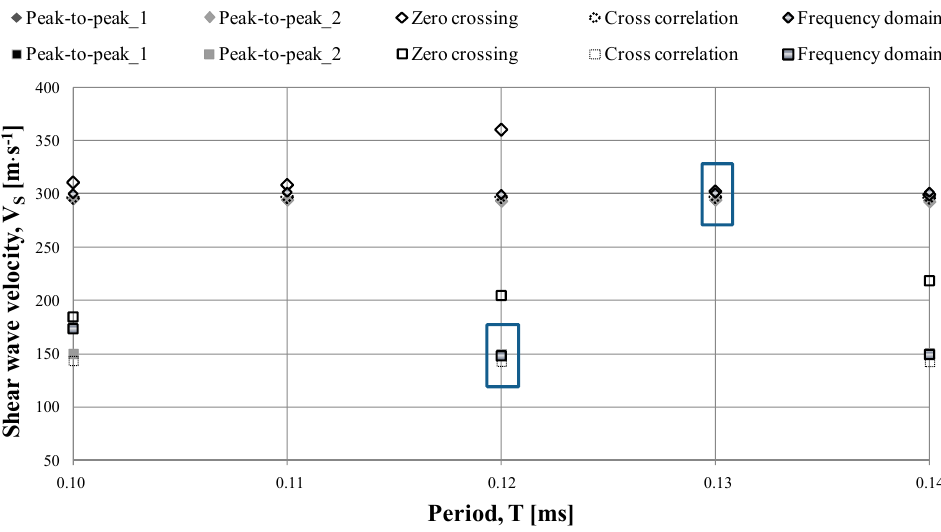
Figure 11. Variation of V S with period for p ′ = 180 kPa. Diamond symbols: pure RCA specimens; rectangle symbols: compositions of RCA with rubber chips.